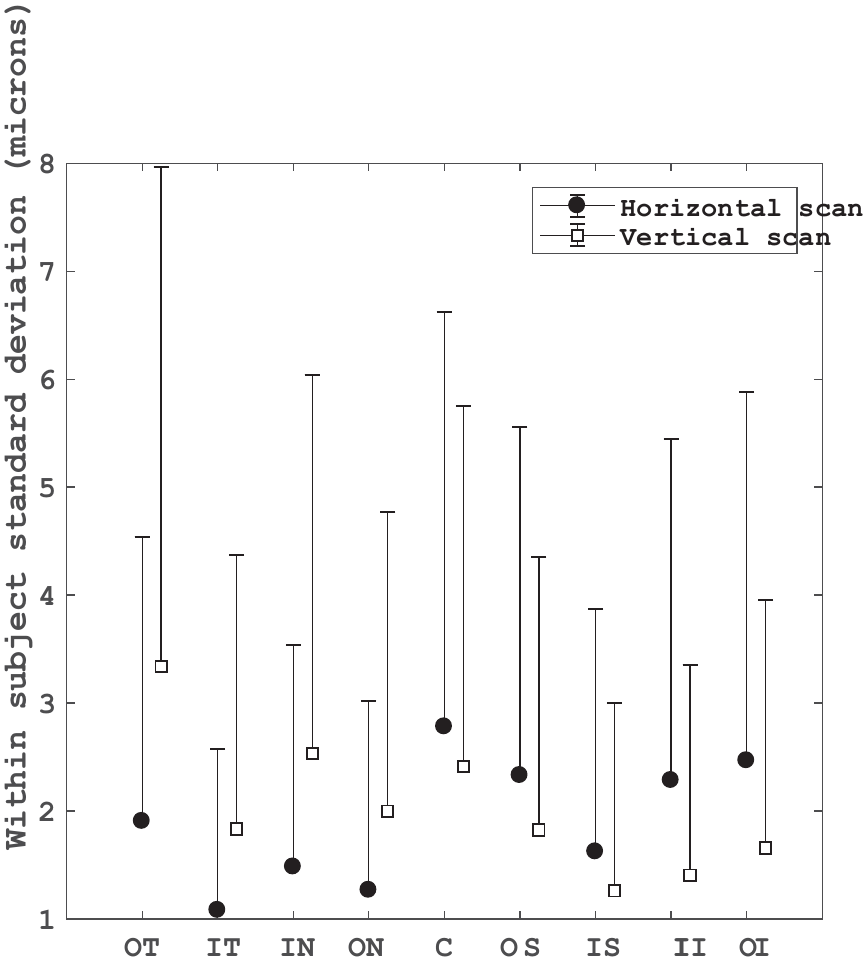
Fig 2. Intra-device repeatability for the inner limiting membrane to retinal pigment epithelium thickness in different sectors for horizontal and vertical scans. OT: outer temporal, IT: inner temporal, IN: inner nasal, ON: outer nasal, C: central circle, OS: outer superior, IS: inner superior, II: inner inferior, OI: outer inferior